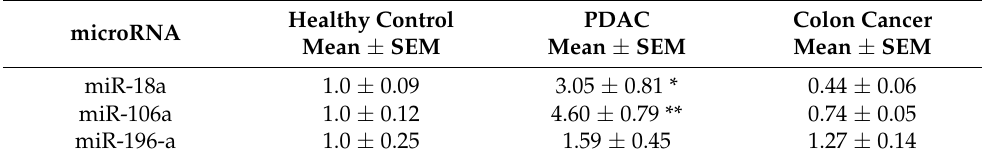
Table 5. Colon cancer patients included in this